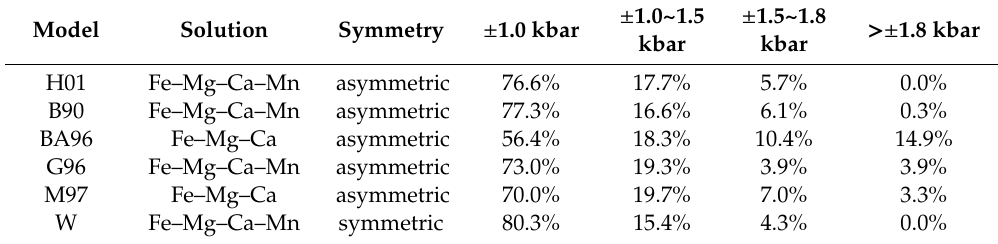
Table 2. Pressure accordance of samples (Table S1) determined by the GASP geobarometer [49] and the garnet geobarometers incorporating di ff erent activity models of garnet based on data listed in Table S1. Model